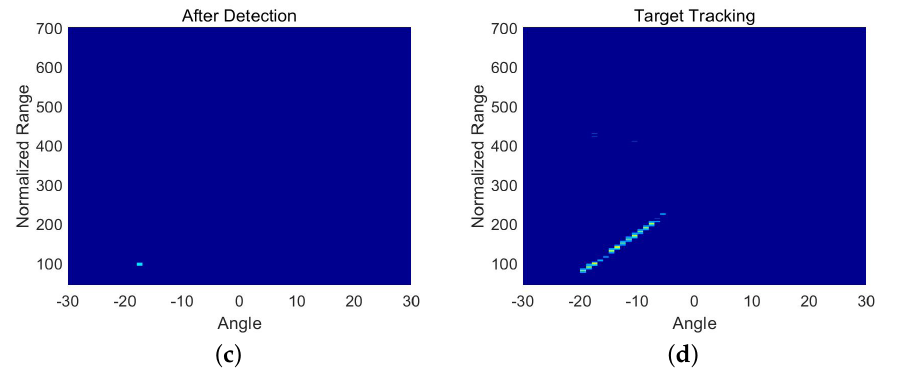
Figure 1. Detection results of the virtual target. ( a ) is one frame of data in beamspace before detection; ( b ) is the sparse component of the corresponding frame data; ( c ) is the detection result of corresponding frame data; ( d ) is the trajectory of the